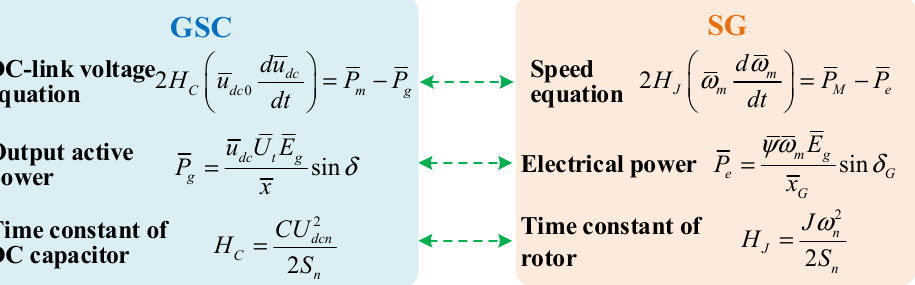
Figure 1. Similarity of the dynamic equations between the GSC and the SG.